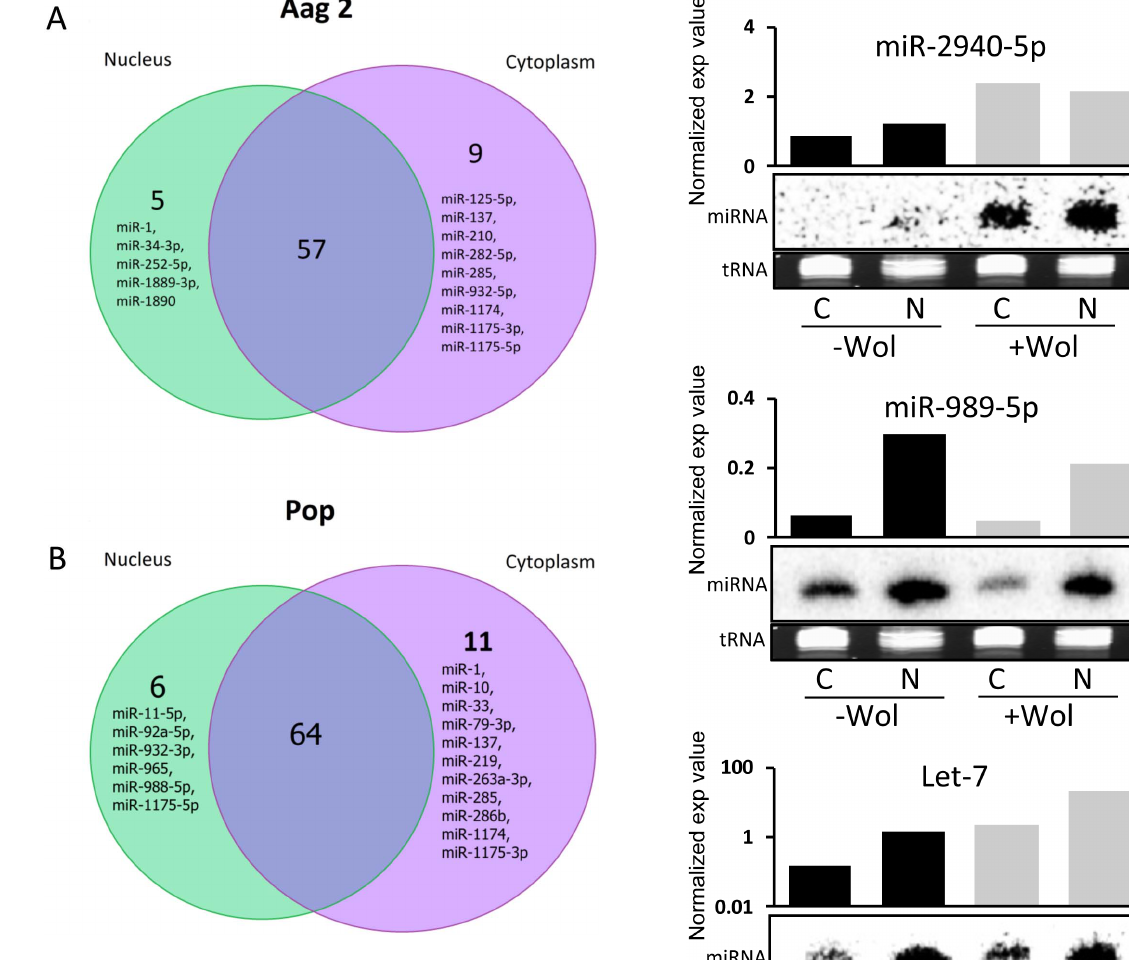
Figure 3. Differentially expressed miRNAs in the nucleus and the cytoplasm of (A) Aag2 cells and (B) cells infected with Wolbachia (Pop).